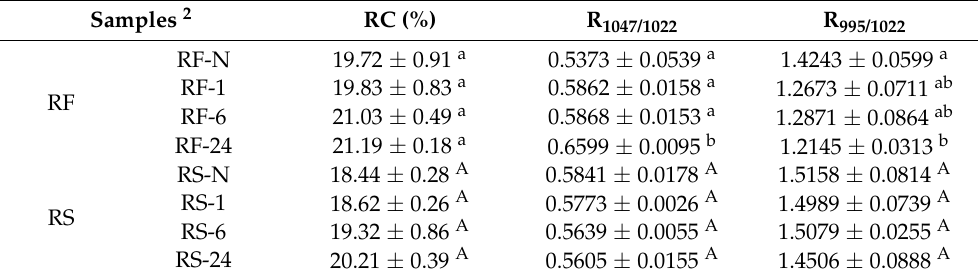
Table 3. The XRD and FTIR parameters 1 of native and partially hydrolyzed RF and